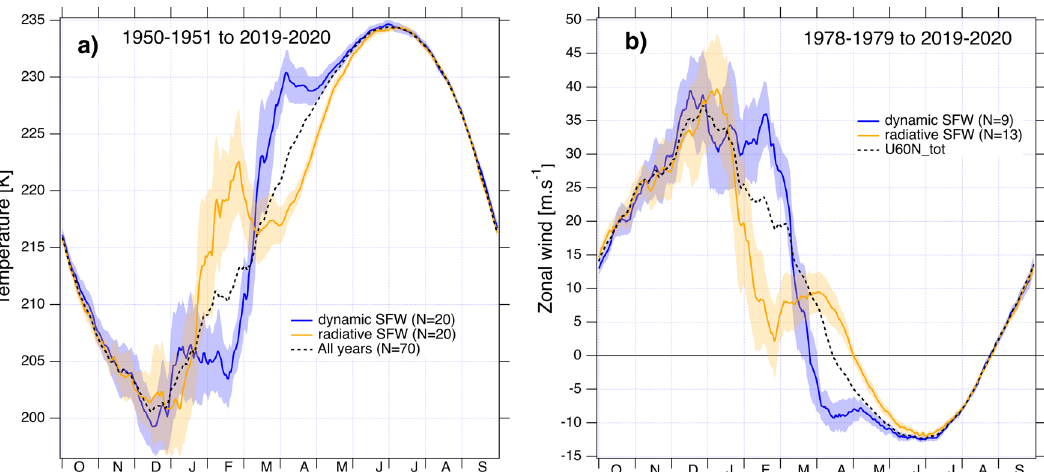
Fig. 3 Polar temperature and zonal wind evolution for the two composites. a Evolution of the polar temperature and, b of the 60°N zonal wind (for the two SFW composites with 20 dynamical SFWs (in dark blue) and 20 radiative SFWs (in light orange). The shaded area represents the 95% con fi dence level (2 standard deviations) on the mean values. The dashed black line represents the evolution averaged over the 70 years.